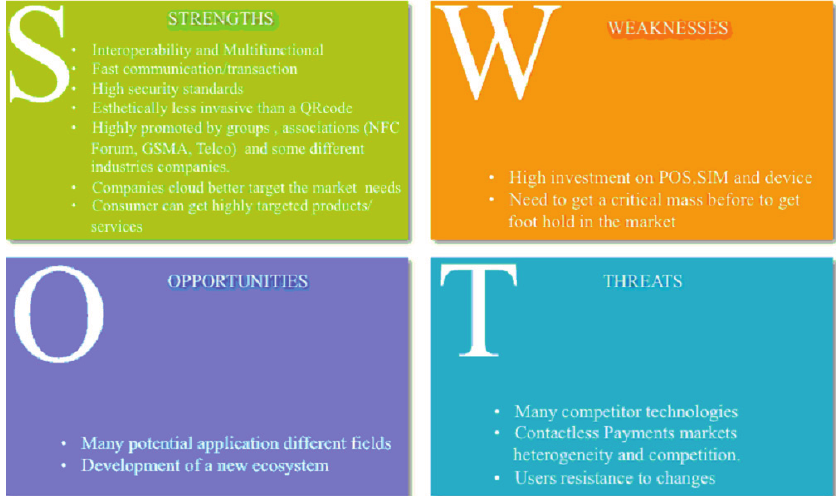
Figure 3. NFC Technology SWOT Analysis (source: authors’